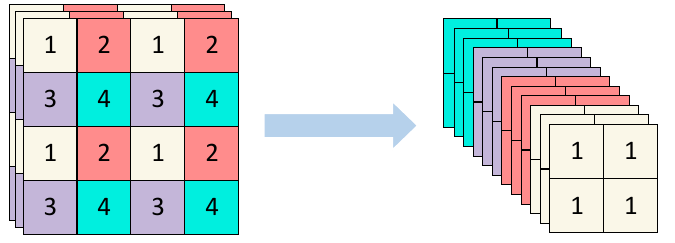
Figure 2. Structure of Focus slices.